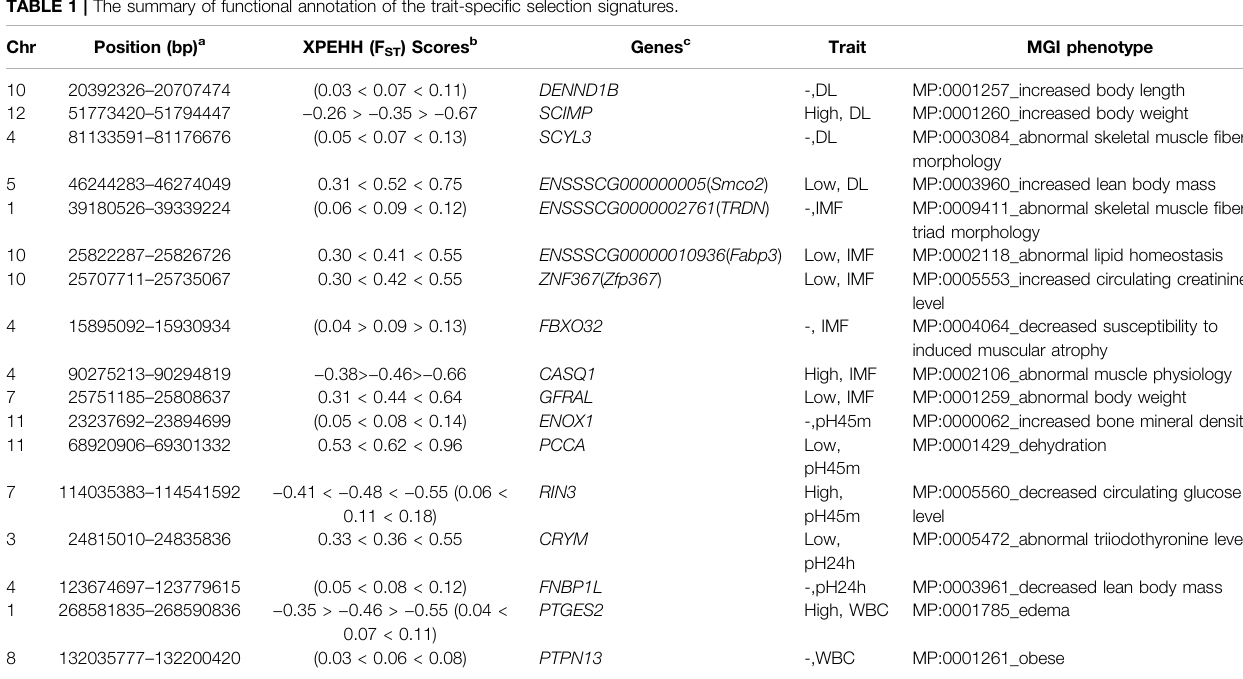
TABLE 1 | The summary of functional annotation of the trait-speci fi c selection signatures. Chr Position (bp) a XPEHH (F ST ) Scores b Genes c Trait MGI